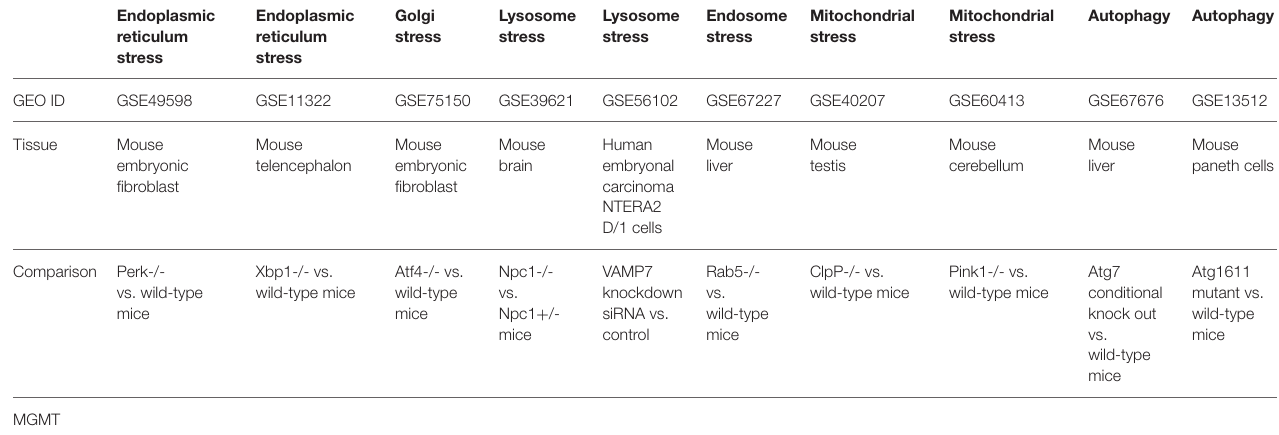
TABLE 3 | The gene expression changes of DNA damage repair factors in response to intracellular organelle stress. Endoplasmic reticulum